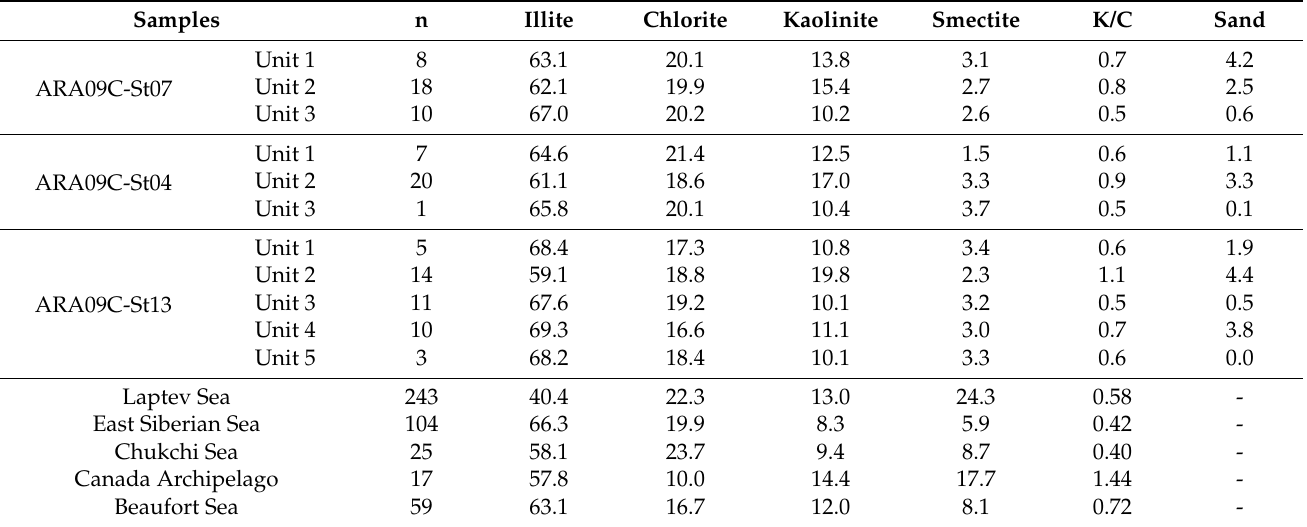
Table 3. Average clay mineral and sand compositions (%) and K/C ratio in the studied cores and their potential provenances [29–32]. Raw data provided in Table S2 in Supplementary Materials. K/C: